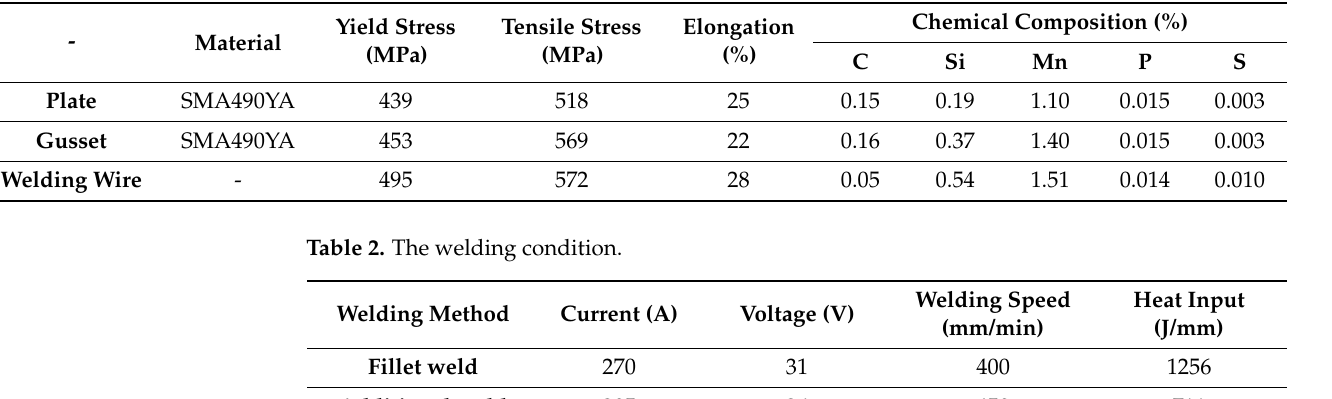
Figure 9. The verification of the modified spline model: ( a ) the welding conditions (unit: mm); ( b ) B1; ( c ) B2; ( d ) B3. Table 1. The mechanical and chemical composition of the material.